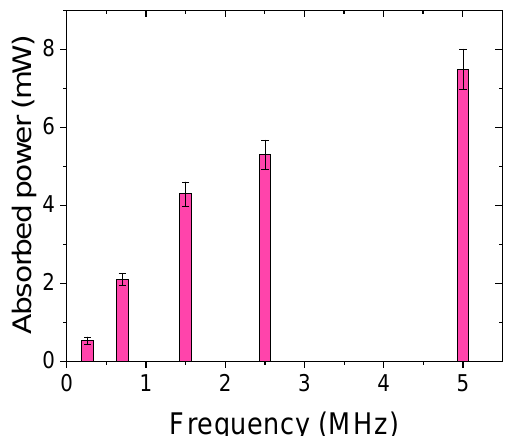
Figure 4. Acoustic power absorption by 1 wt% PNIPAM solution subjected to ultrasound waves in different frequencies. According to the literature [21], imposing ultrasound waves on a liquid generates translational movement of the liquid molecules which is called acoustic streaming. The question is how the turbidity evolution can be related to this acoustic streaming. Do all hydrogen bonds break at the bottom of the glass cuvette and will all the collapsed micro-